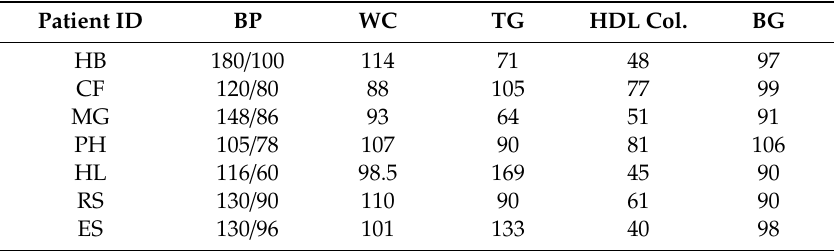
Table 3. Baseline data of seven MetS patients with 3 / 5 CVD risk factors. The shadowed cells indicate the treated conditions. BP, Blood Pressure: (mmHg); WC, waist circumference (cm); TG: Triglyderides